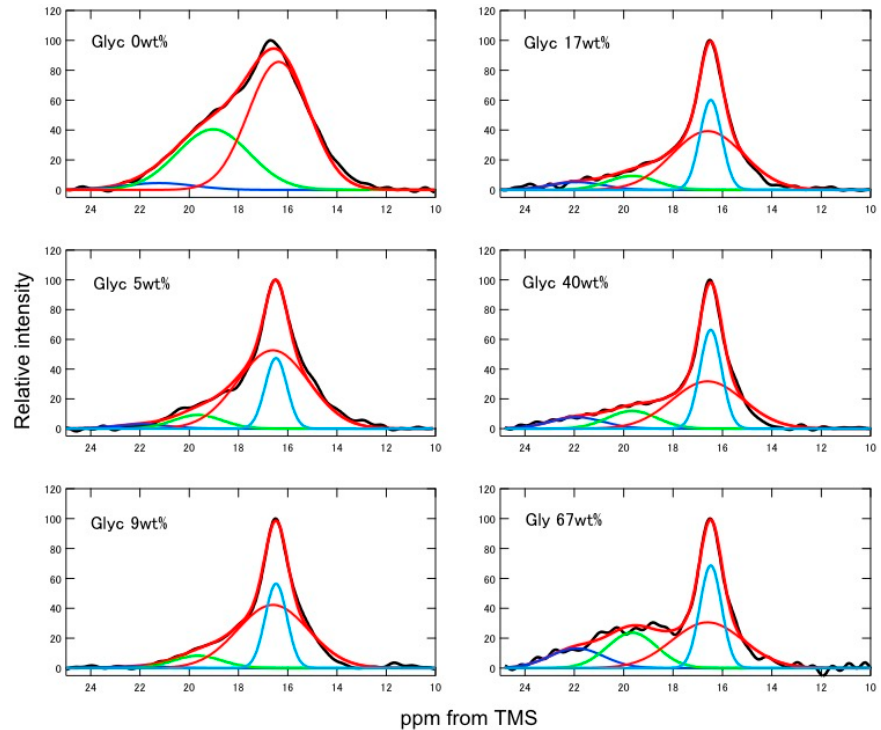
Figure 2. Deconvolution of Ala C β peaks (marked by red (random coil), light blue (Silk I*), dark blue ( β -sheet B) and green ( β -sheet A) lines) in the 13 C CP/MAS NMR spectra of SF and Glyc-blended SF films as a function of Glyc concentration by assuming Gaussian line shape. TMS, tetramethylsilane. During the preparation of the regenerated SF films (including the drying process), partial conformational change from random coil to β -sheet occurred, especially in the crystalline domain, which consisted of repeated AGSGAG sequences as reported previously [34]. By adding a small amount of Glyc (only 5 wt %) to SF, a remarkable change in the spectrum occurred. In particular, Silk I* form appeared partly as marked by light blue curve (Figure 2), viz. the peak with the narrower linewidth but the same chemical shifts as that of broad random coil peak. Thus, the Silk I* structure has a narrower chemical shift distribution than that of the random coil. In addition, β -sheet A in the spectrum of the SF sample without Glyc decreased considerably in intensity.